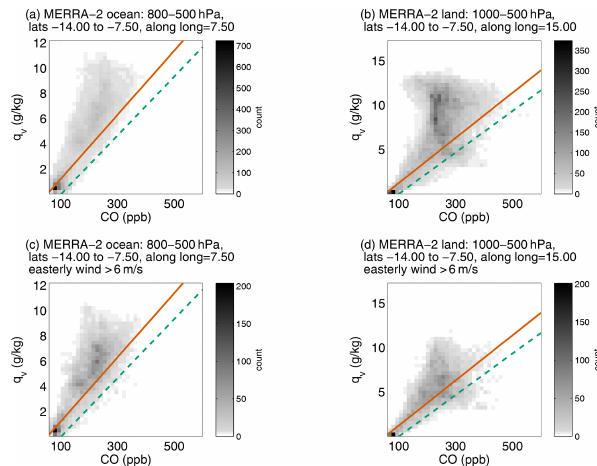
Figure 13. MERRA-2 CO and water vapor over land and over ocean, for (a, b) all observations along 15 and 7.5 ◦ E and (c, d) only observations for which easterly wind speed was > 6m/s. For orien- tation with previous results, the dashed green line is the fit through all ORACLES-2016 free-troposphere flight data and the solid red line shows the MERRA-2 fit coincident with the aircraft observa- tions (both as in Fig. 7). A vertically resolved version of this plot is shown in Fig. S5. The results are largely similar for WRF-CAM5 and WRF-Chem (Fig.